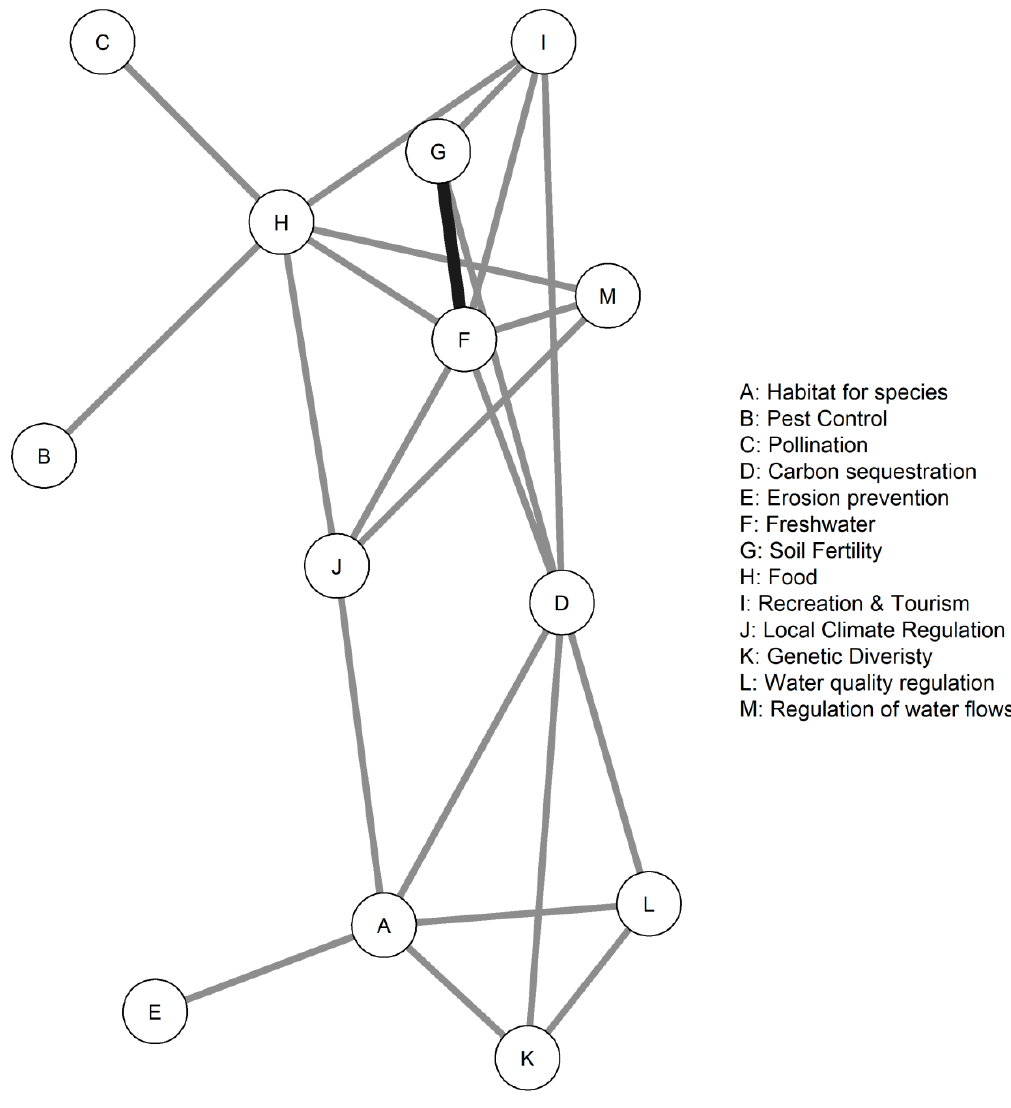
Figure 6. A network diagram showing the linkages between different agroecosystem services in studies that identified ecosystem service